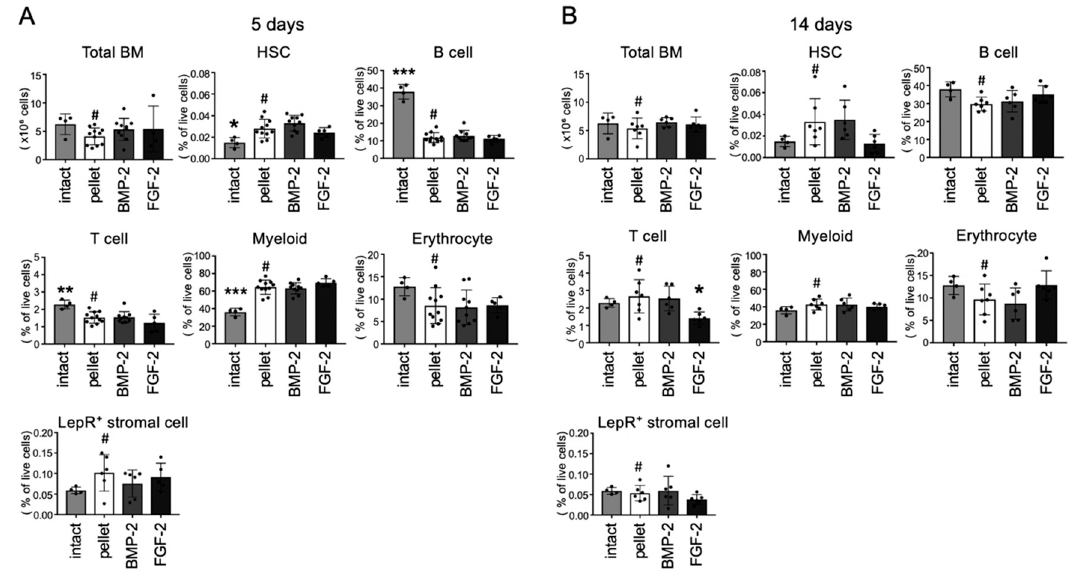
Figure 6. Effects of BMP-2 and FGF-2 on bone marrow cell populations. Collagen pellets containing BMP-2 (10 μ g) or FGF-2 (10 μ g) or DW (control) were transplanted into mouse femur defects and samples were analyzed by FCM at 5 days ( A ) and 14 days ( B ) after transplantation. HSCs: Lin − Sca-1 + c-Kit + CD150 + CD48 − , Erythroid cells: Ter119 + , Myeloid cells: CD11b + Gr-1 + , B cells: B220 + , T cells: CD3 + , Leptin R + stromal cells: CD45 − Ter119 − CD31 − LepR + ( n = 4–11, * p < 0.05, ** p < 0.01, *** p < 0.001 versus control pellet (#). One-way ANOVA/Tukey).